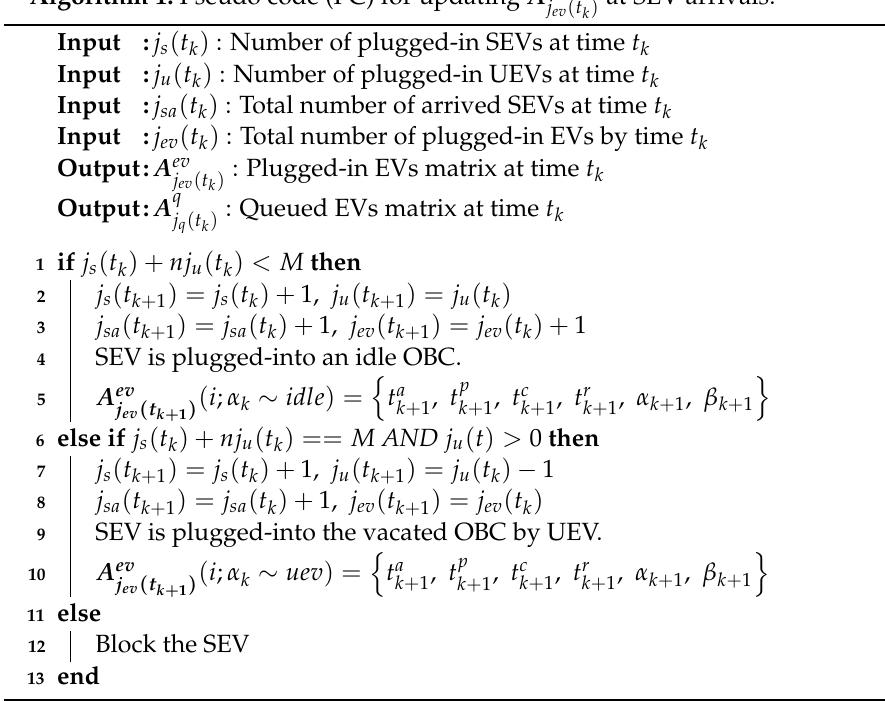
Algorithm 1: Pseudo code (PC) for updating A ev